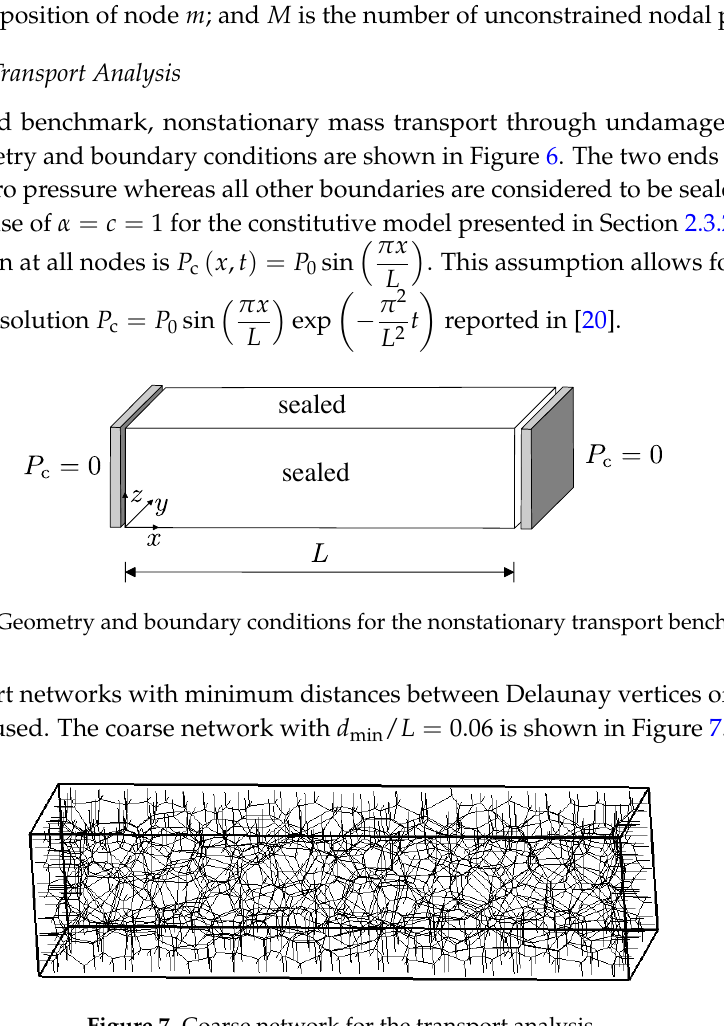
Figure 7. Coarse network for the transport